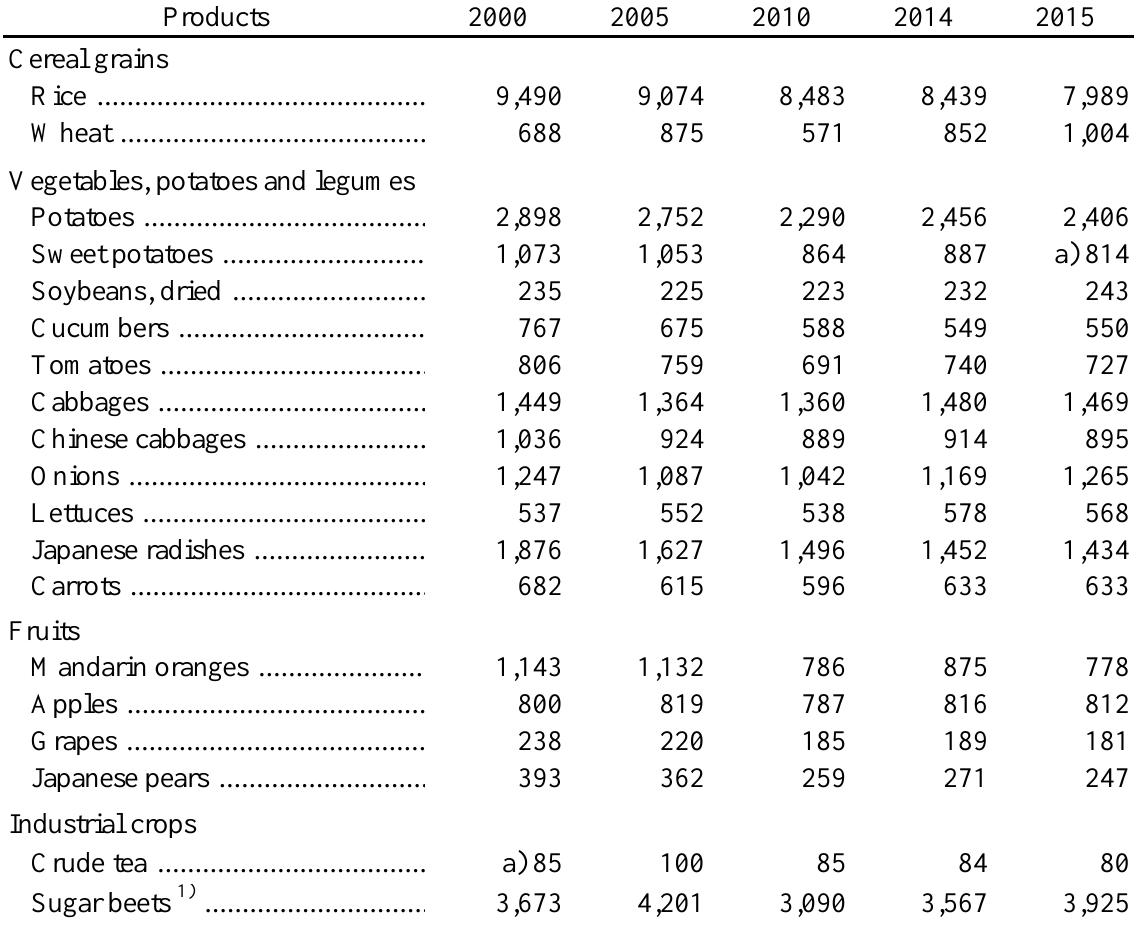
Table 5.2 Agricultural Production